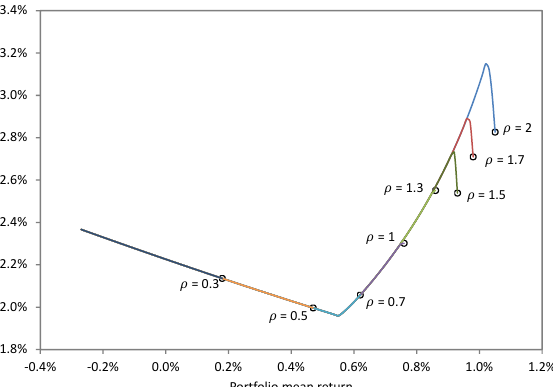
Figure 7. Slippage loss of trading as a fraction of initial wealth as target mean and leverage